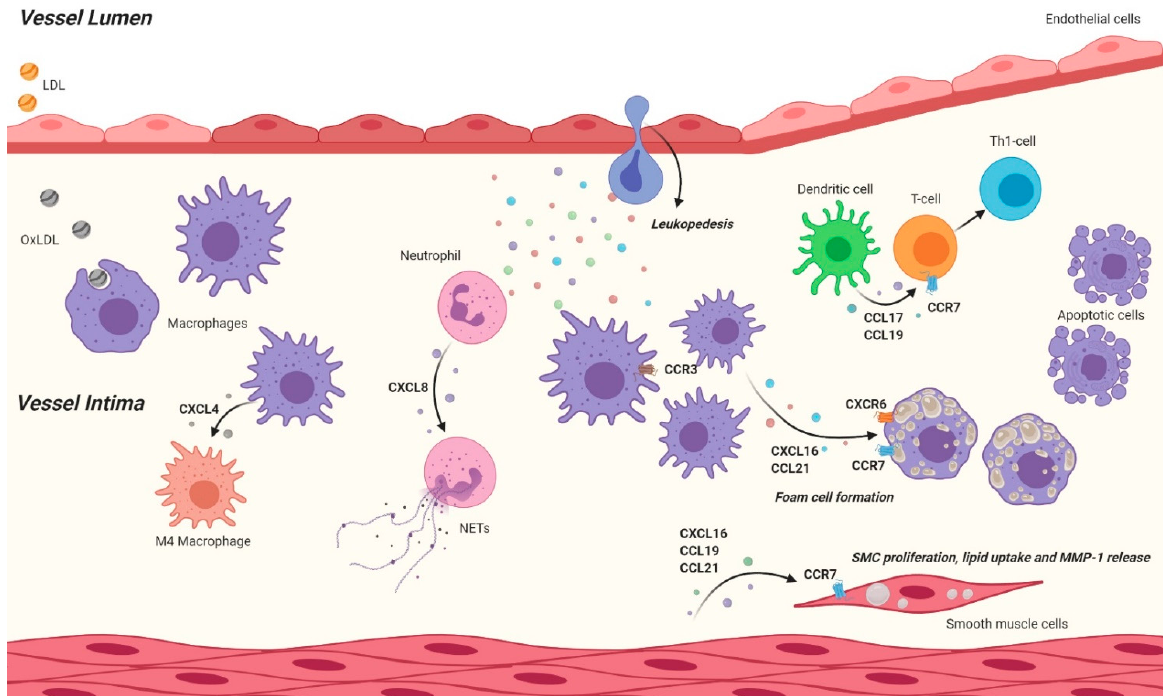
Figure 2. Schematic and simplified overview of the effects that chemokine-chemokine receptor axis have on atherosclerotic processes inside the vessel wall. In the vessel wall, various chemokines and chemokine receptors play an important role in cellular processes. Secreted chemokines contribute to the leukopedesis and stimulates foam cell formation. Furthermore, chemokines contribute to macrophage polarization and the formation of neutrophil extracellular traps (NETs). Besides effects on myeloid cells, also lymphocytes are affected as dendritic cell mediated T cell activation is stimulated by chemokines. Finally, chemokine and chemokine receptors contribute to smooth muscle cell (SMC) proliferation, lipid uptake and release of matrix metalloproteases. (Created with Biorender.com)